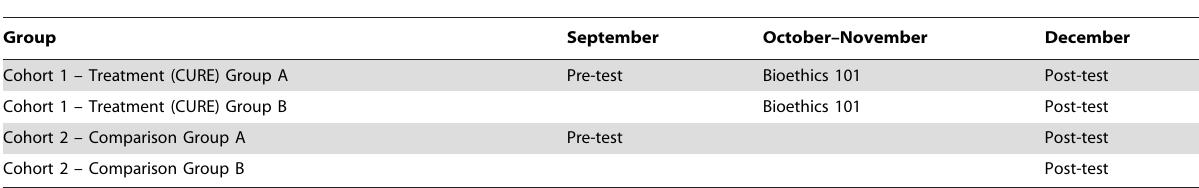
Table 1. Four-Group Research Design.